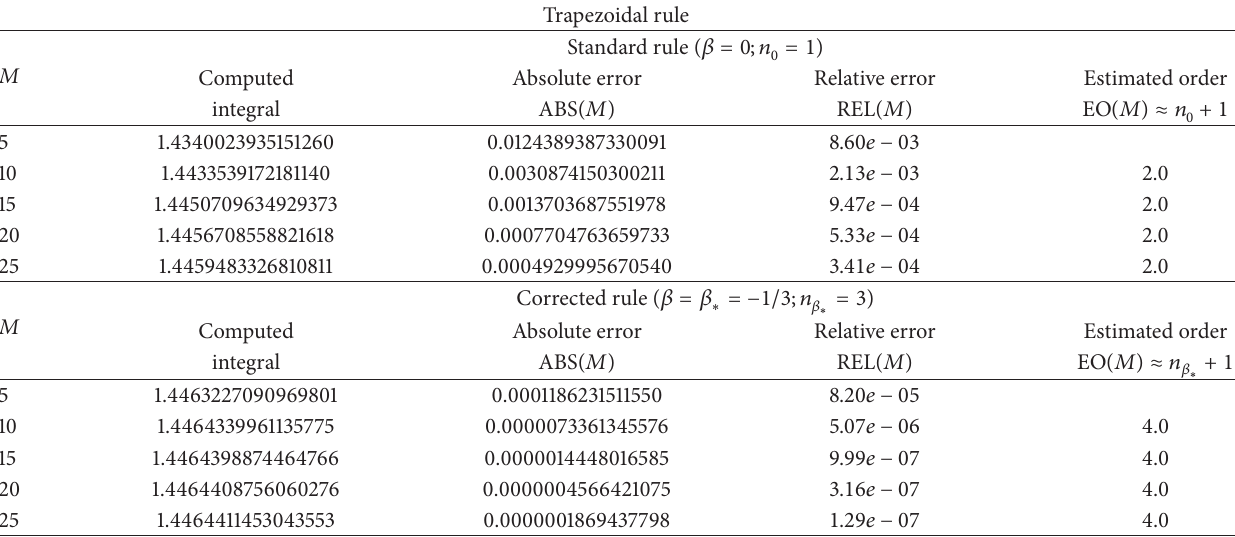
Table 5: Results for the trapezoidal